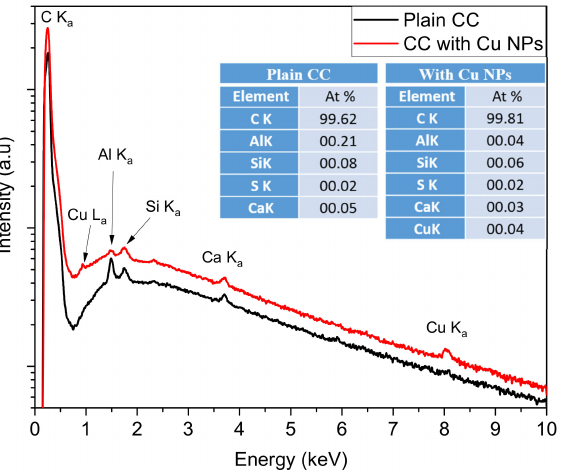
Figure 4. EDS spectra of plain CC (black line) and CC coated with Cu NPs (red line). The inset tables show the corresponding elemental atomic composition of these